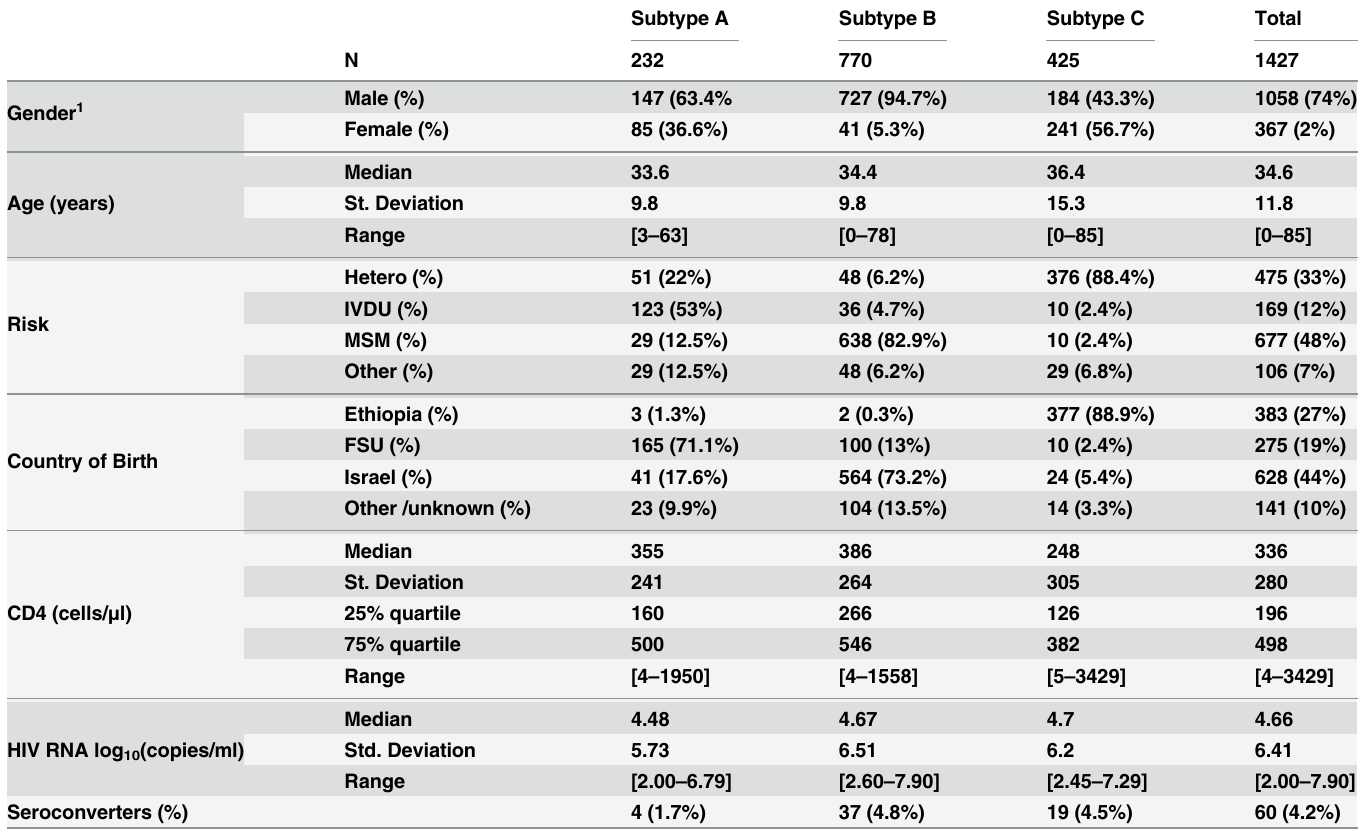
Table 1. Demographic characteristics, clinical data and